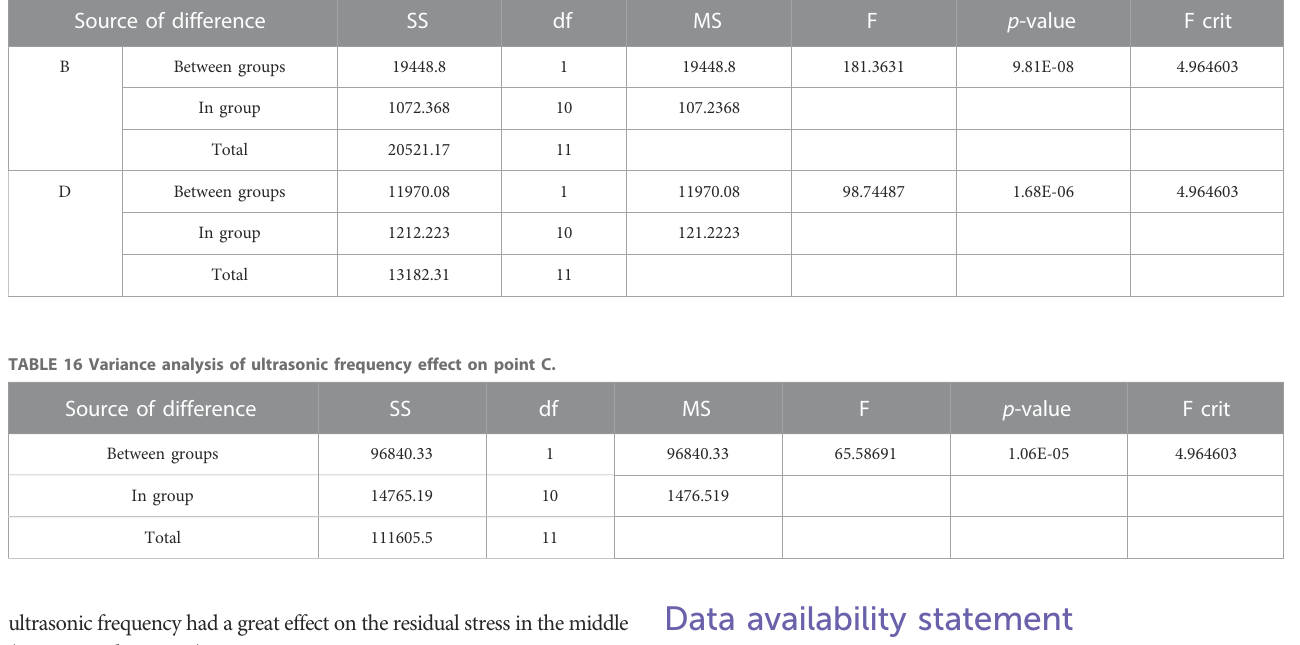
TABLE 15 Variance analysis of ultrasonic frequency effect on point B and point D. Source of difference